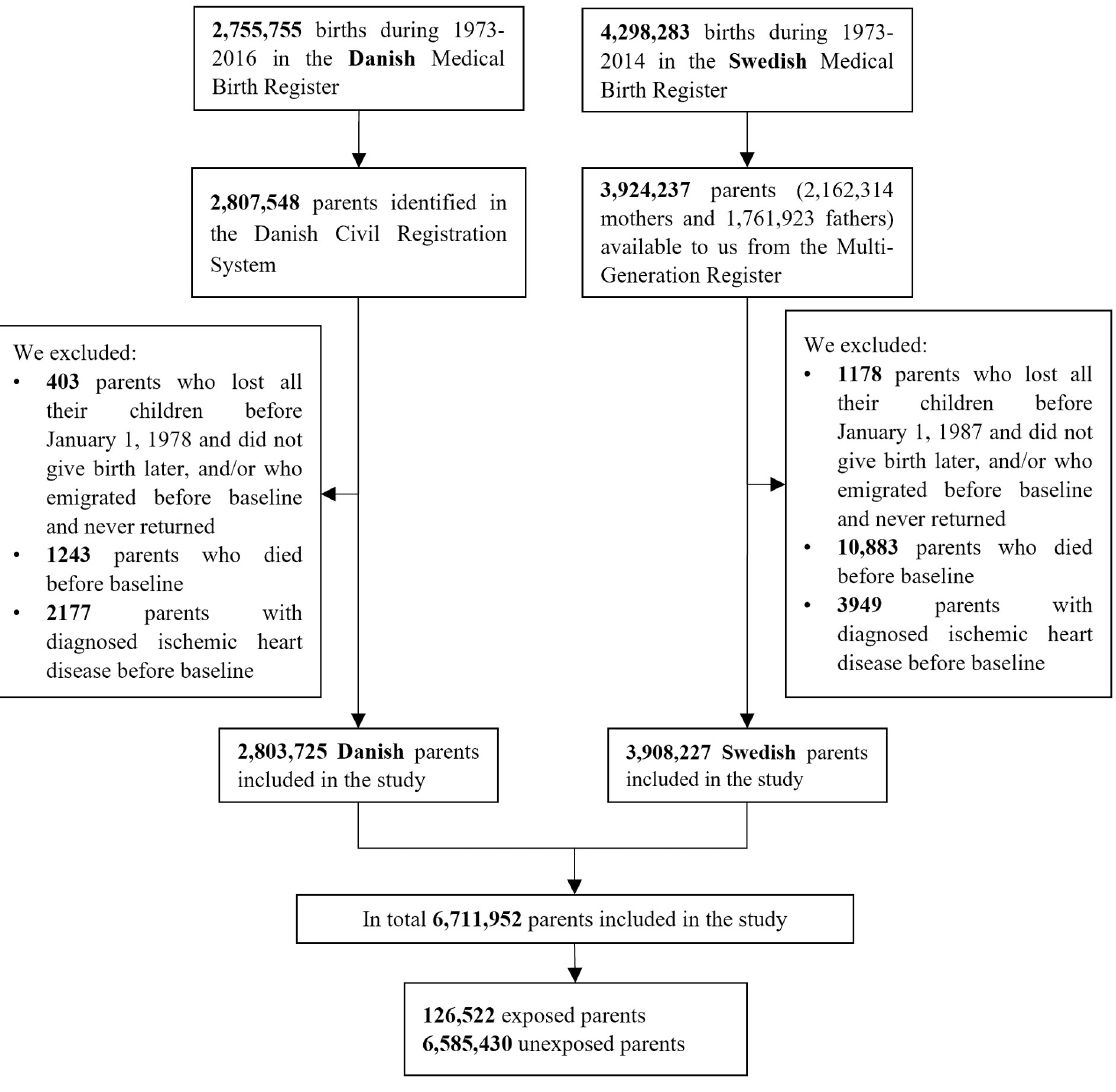
Fig 1. Flow chart of the